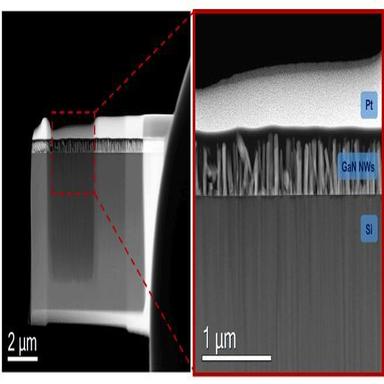
STEM-HAADF overview of a FIB lamella of GaN nanowires. Note that the central part of the lamella was thinned and polished at low energy afterwards. The inset details the final aspect of the thinned region.